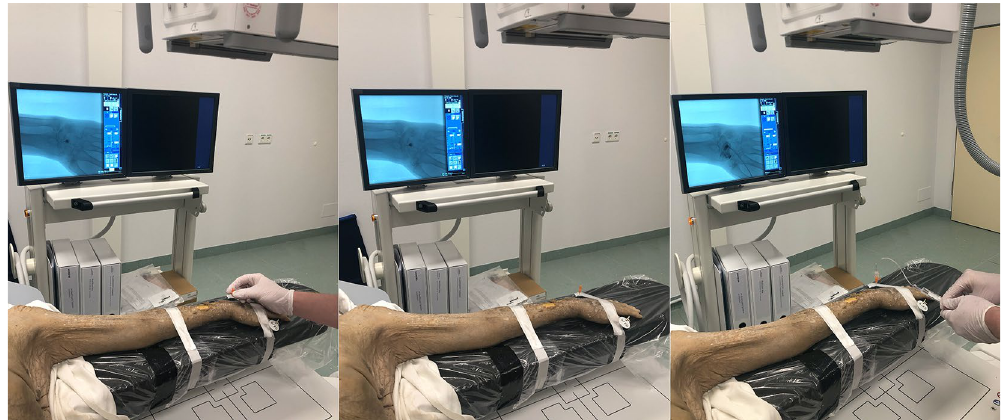
Figure 2. Fluoroscopy-guided arthrography of the midcarpal joint of a cadaveric specimen using the tableside scan trajectory of the twin robotic x-ray system. The specimen remained in the same position for the ultra-high- resolution cone-beam CT scans, allowing for a very short examination time.